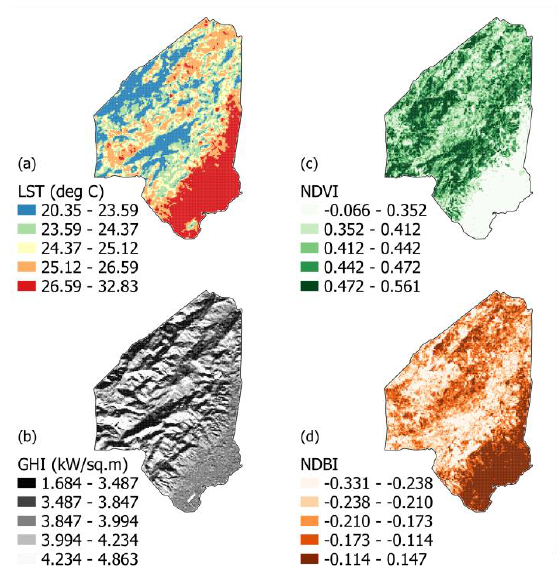
Figure 9. Seasonal averages of a) LST, b) GHI, c) vegetation, and d) built-up indices in Cebu City for the cool dry season, resampled to a 120x120m